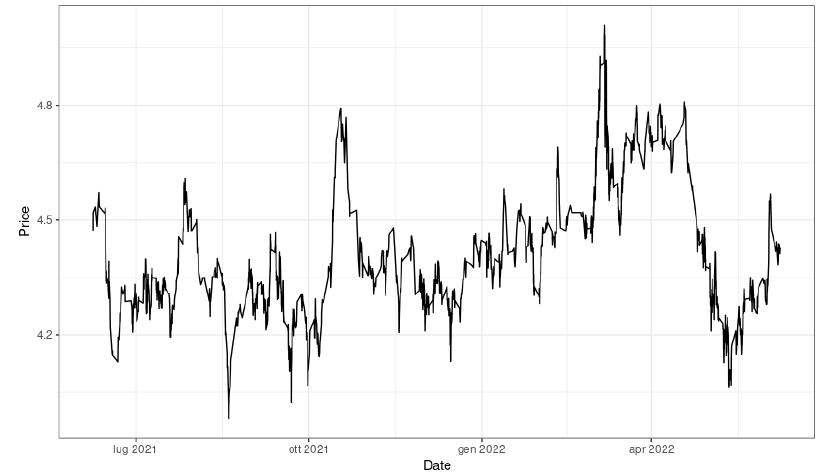
Figure 2. Temporal behavior of intraday prices { P ( t ) } n